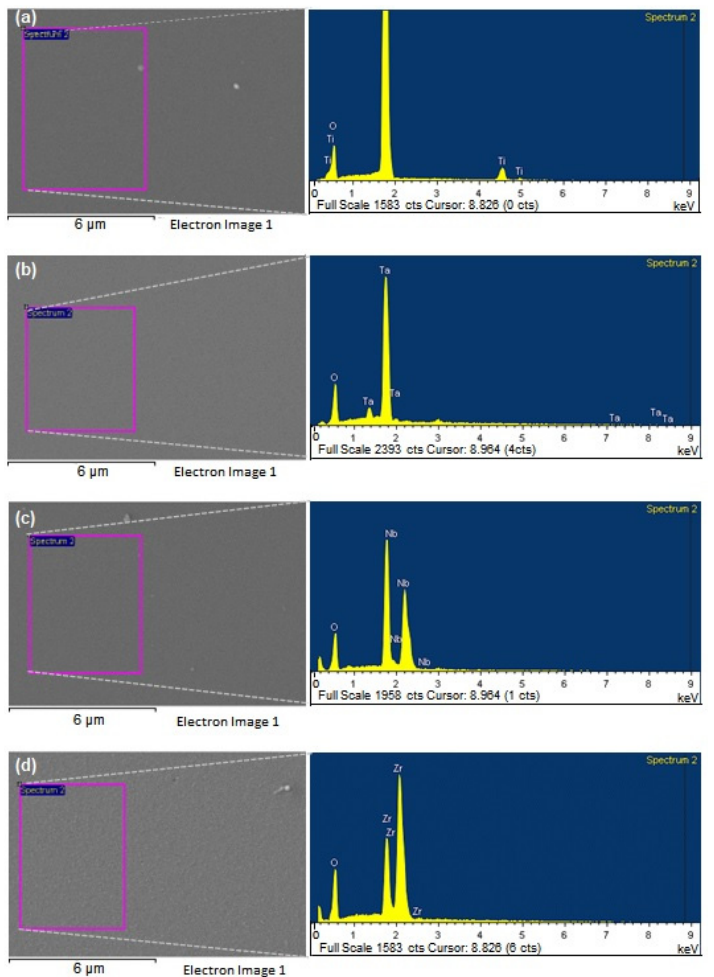
Figure 2. Representative SEM images of the areas analyzed (pink rectangles marked on the micro- graphs) for EDS elemental composition studies and of the corresponding EDS spectra obtained for the ( a ) TiOx; ( b ) TaOx; ( c ) NbOx; and ( d ) ZrOx coated samples. Table 1. Coatings elemental composition as obtained from EDS analysis.